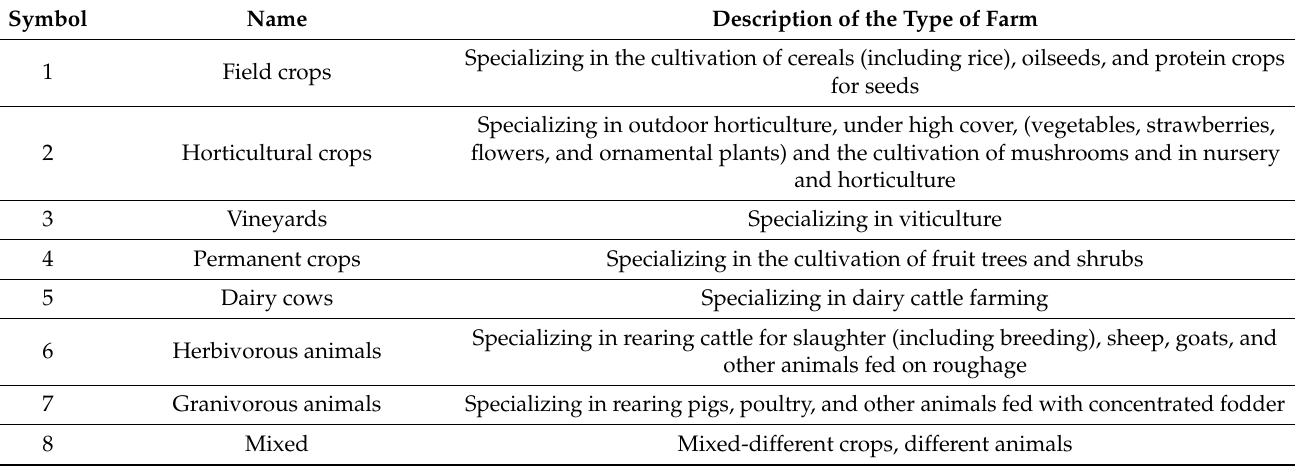
Table 2. Grouping of farms by type.